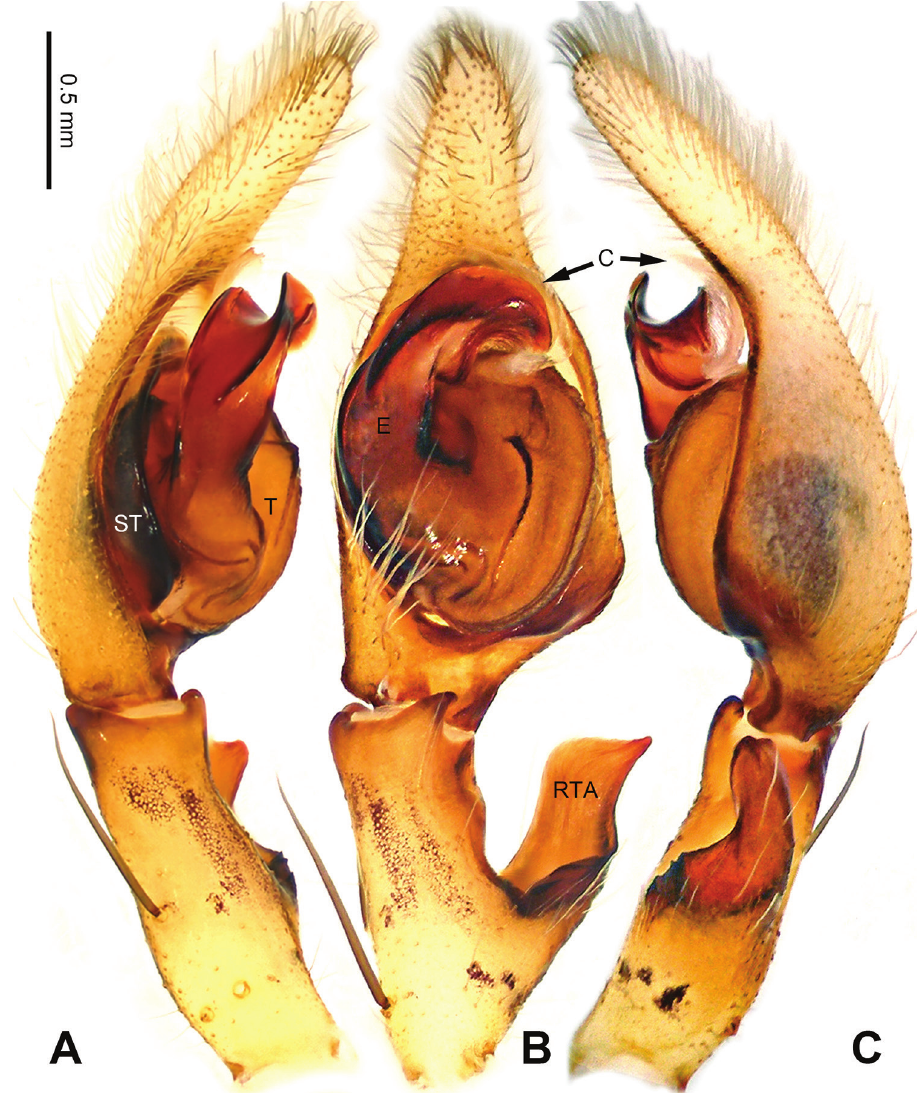
Figure 31. Pseudopoda xia Zhao & Li, sp. n., left palp of male holotype. A Prolateral view B Ventral view C Retrolateral view. Scale bar equal for A, B, C